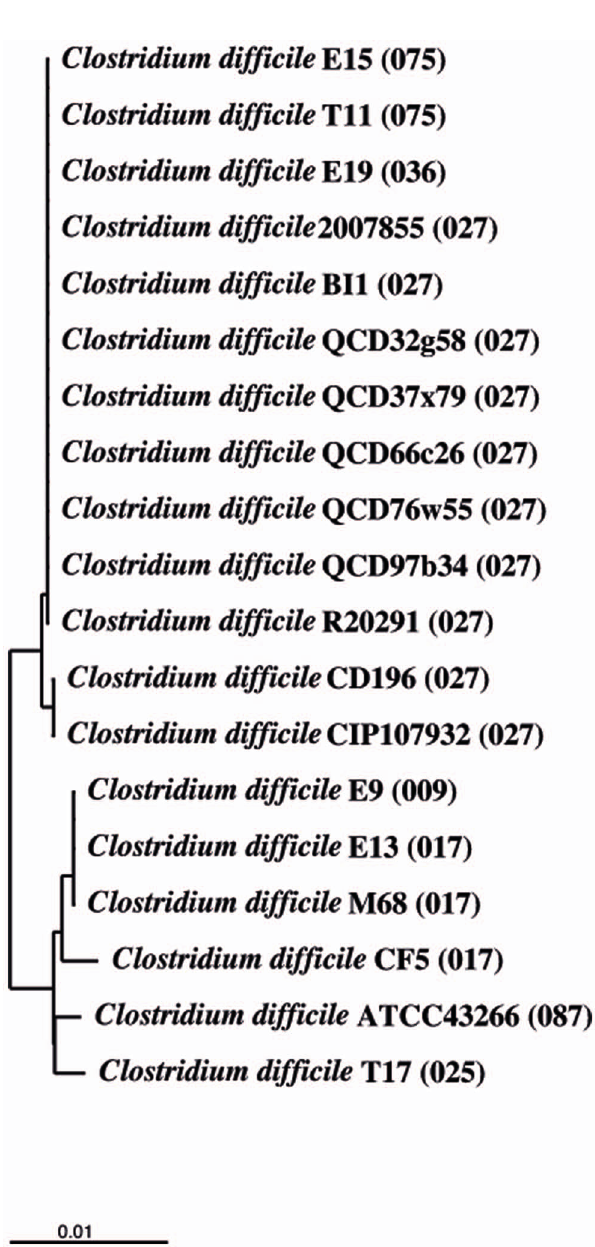
Figure 3. Virulence associated protein e gene-based dendro- gram. Neighbor joining dendrogram reflecting the similarity for 19 C. difficile strains based on the gene for virulence associated protein E. The distance matrix was computed using the Hamming distance with the virulence associated protein E genes from the 19 C. difficile isolates containing this gene. The strains always cluster together according to their PCR-ribotype. The PCR-ribotype is indicated in brackets. The strains with ribotype 027 sub-cluster into two different groups. clustered in the other group. The first group only differs by two nucleotides from the second group. The nucleotide at position 772 is cytosine in the first group but adenine in the second group, resulting in threonine or asparagine residues, respectively, at the corresponding amino acid sequence positions. The other differ- ence is at nucleotide position 992, were either cytosine (group 1) or thymine (group 2) is found, with no consequence for the amino acid sequence.